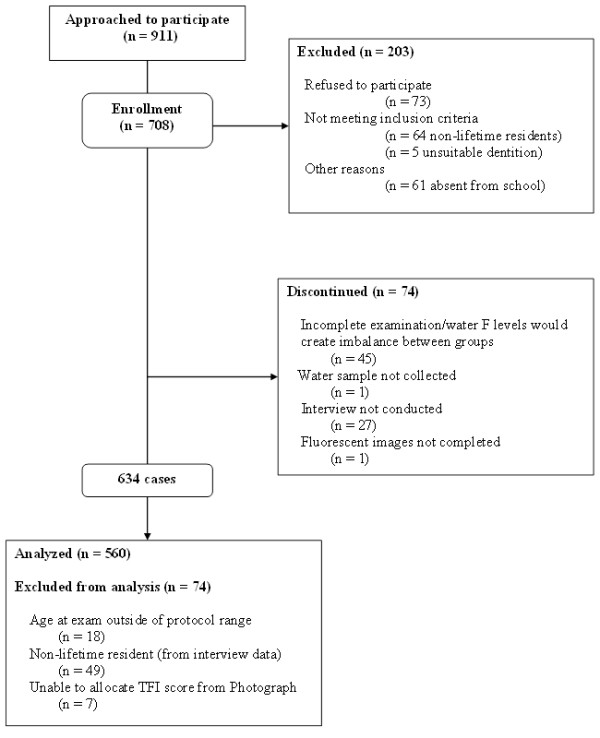
Subject accountability illustrating flow of subjects through each stage of the study.